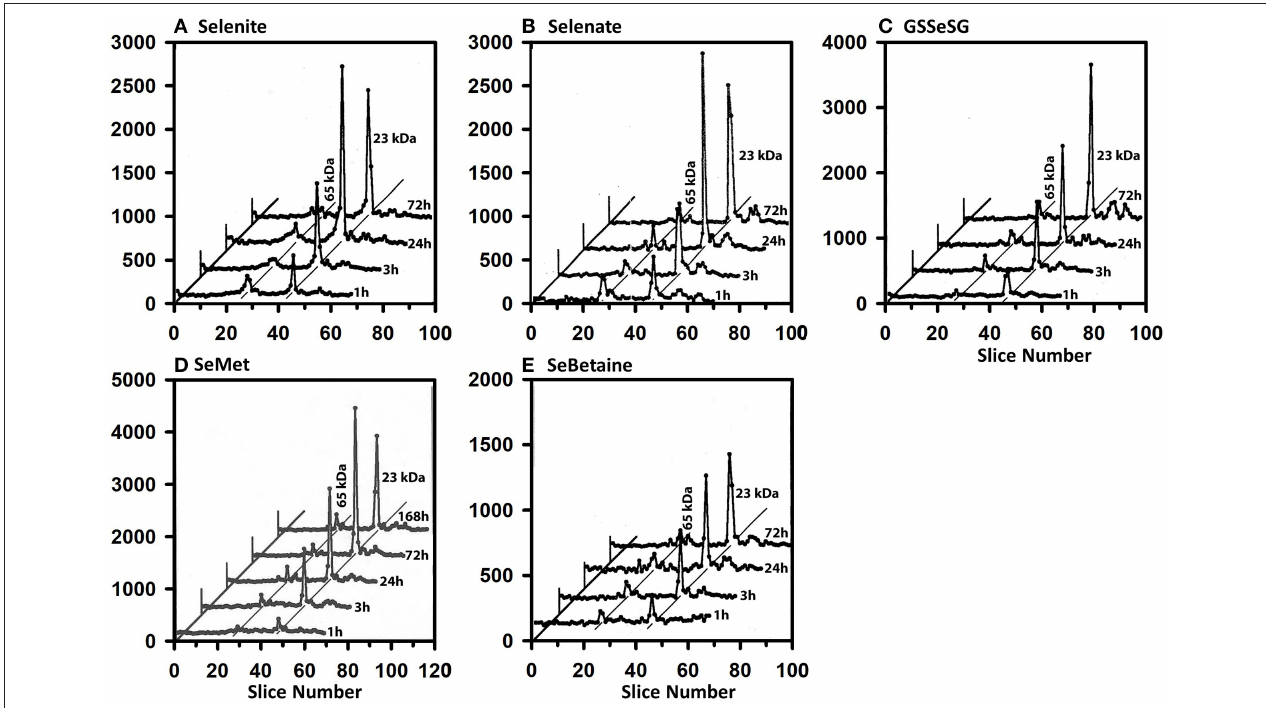
FIGURE 4 | Incorporation of 75 Se into liver cytosolic proteins from Selenite (A) , Selenate (B) , GSSeSG (C) , SeMet (D) , and SeBetaine (E) . Rats were treated as described for Figure 3 . After homogenization and centrifugation at 105,000g × 60min, cytosols (1,500 µ g protein) were separated using gradient SDS/PAGE as described for Figure 3 ( n = 21 total rats). Liver GPX1 is 23 kDa, and the 65 kDa species are likely to the isoenzymes of